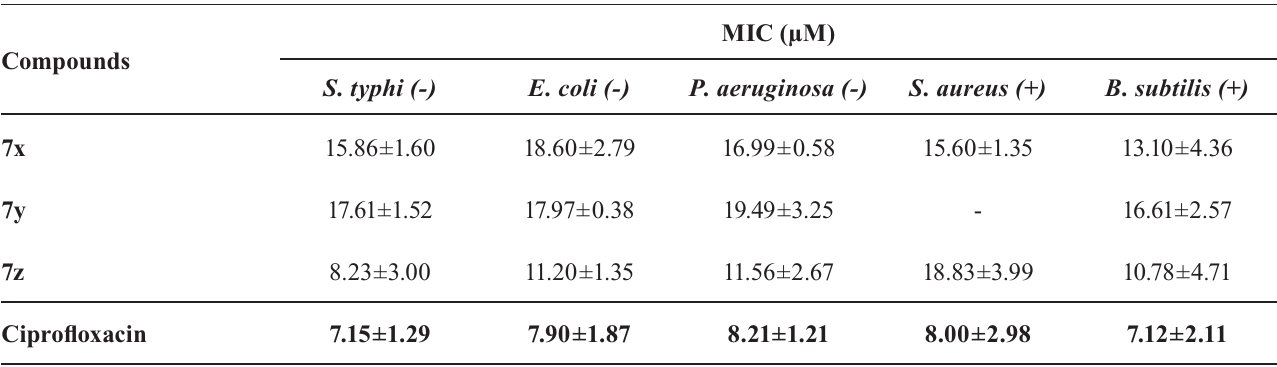
TABLE III - The MIC of antibacterial activity of synthesized compounds